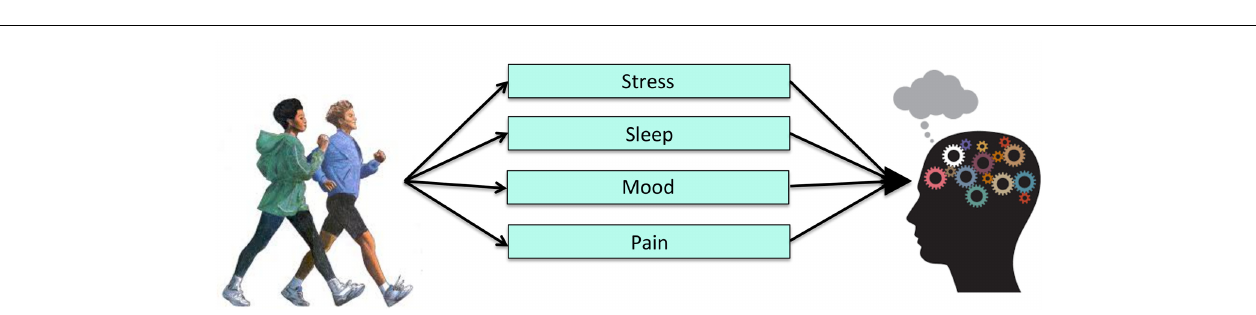
FIGURE 3 | Level 2 of Analysis: Possible brain systems-level mechanisms of PA.